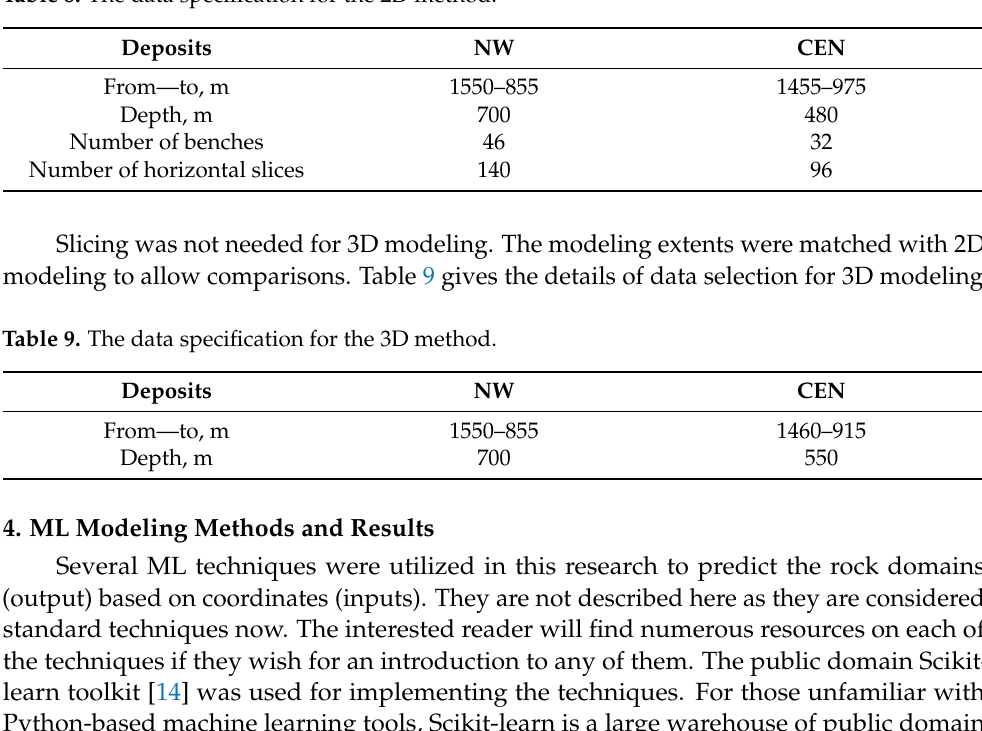
Table 8. The data specification for the 2D method.